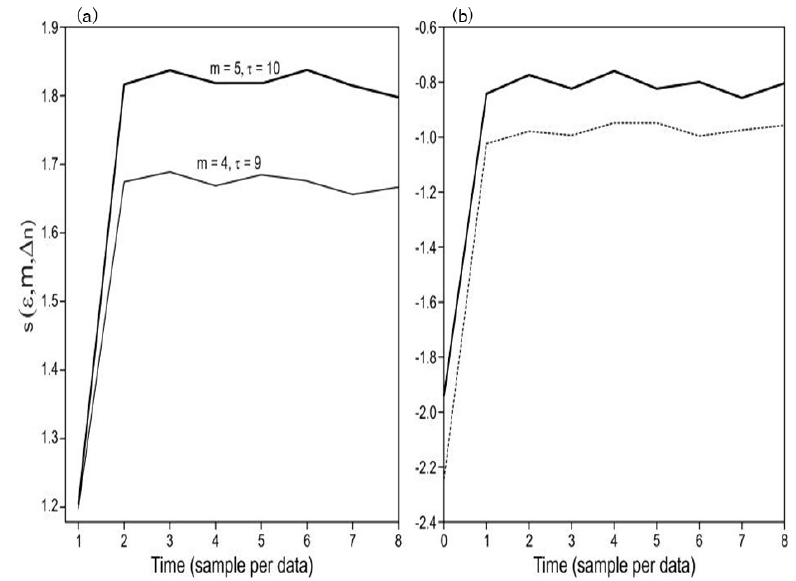
Figure 5. Lyapunov exponent with m = 4, τ = 9 and m = 5, τ = 10, with the Kantz method (a) . Lyapunov exponent with the same values with the Rosenstein method (b) .